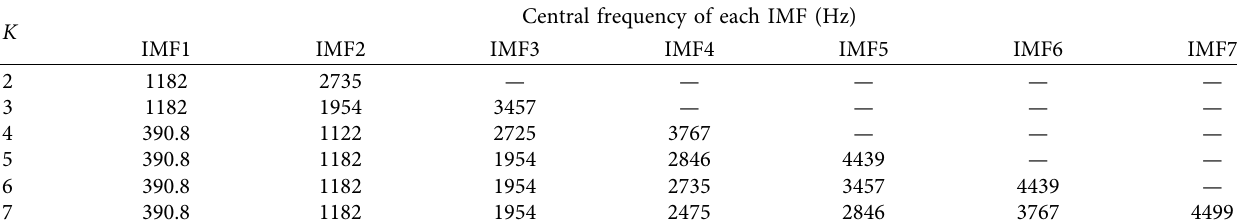
Table 4: Central frequency of each IMF for 3 #